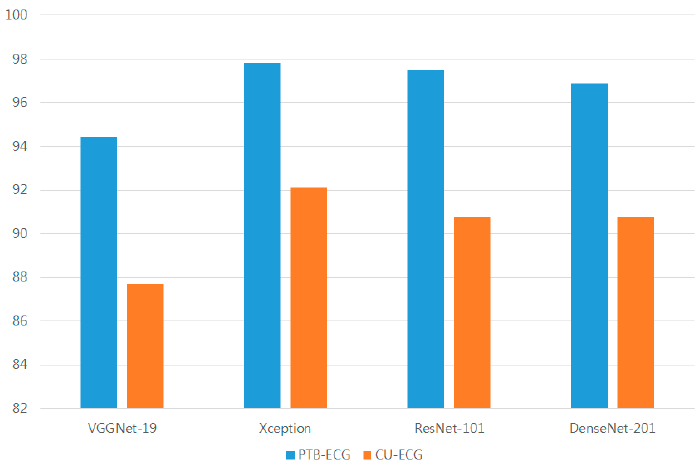
Figure 16. Comparison between the mean accuracies of various models based on CNN.